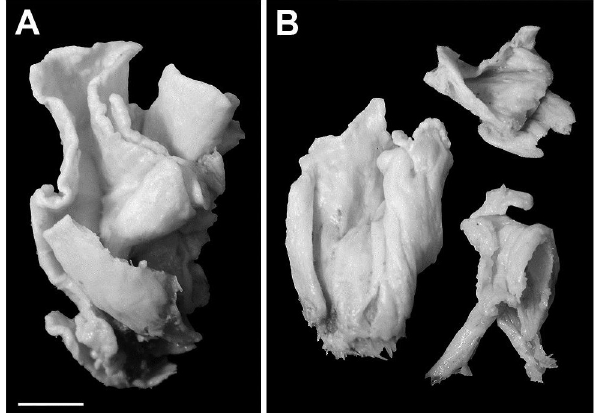
Figure 1. Sinularia mesophotica sp. n.; A Holotype ZMTAU Co 37425 B paratypes ZMTAU Co 37492. Scale bar: 1 cm ( A also applies to B